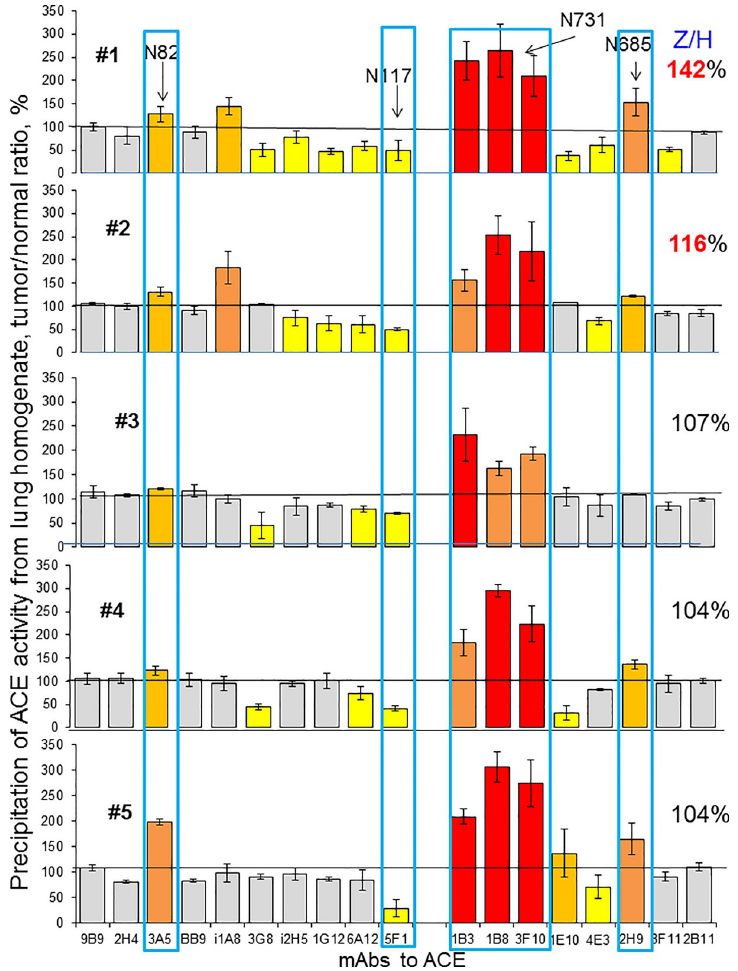
Fig 4. ACE conformation in lung cancer (conformational fingerprinting of ACE). ACE activity was precipitated by 17 different mAbs from five individual homogenates of tumor lung tissues and their morphologically normal lung counterparts. Immunoprecipitated ACE activity is presented as a normalized value (Tumor/Normal ratio), to highlight differences in immunoprecipitation pattern of ACE from different homogenates by different antibodies. ACE activity in these 10 homogenates was quantified before immunocapture and ZPHL/HHL ratio was calculated and presented as a percentage of a value for morphologically normal tissues–values on the right side of the data for each patient. Data presented as a mean of at least 2–3 independent experiments in duplicates. Ratio increased more than 20% are highlighted with orange, more than 50% -with brown and more than 100%—with red. Bars highlighted with yellow- ratio decreased more than 20%, with blue—decreased more than 50%. Bars were highlighted if values were statistically significant ( � p <